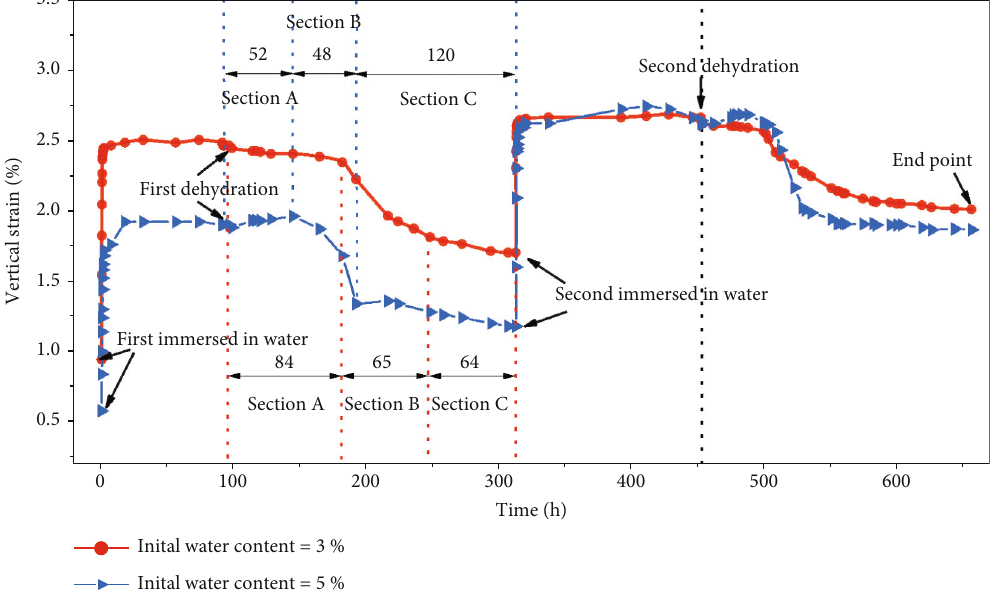
Figure 11: Dry-wet deformation curve of Neijiang